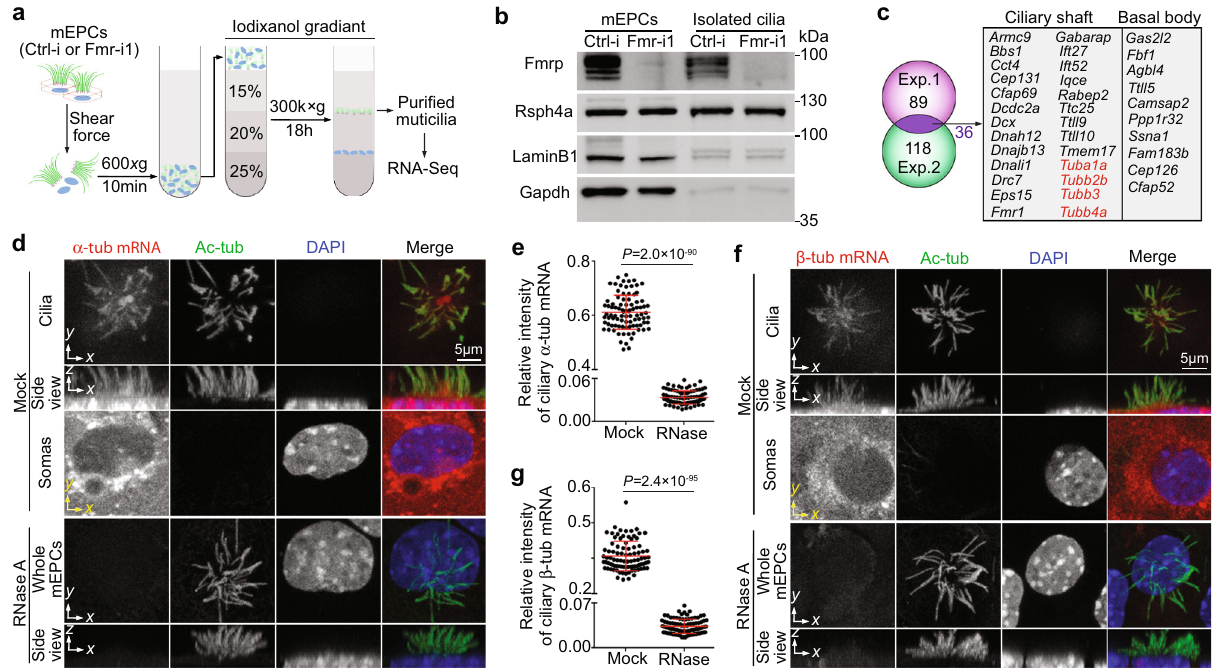
Fig. 7 Ependymal multicilia contain α / β -tubulin mRNAs. Pooled results are presented as mean ± s.d. Two-tailed student ’ s t -test. a Experimental scheme for multicilia puri fi cation. Day-10 mEPCs infected, respectively, with Ctrl-i and Fmr-i1 as illustrated in Fig. 4e were subjected to shear force. The released multicilia were puri fi ed through the iodixanol gradient ultracentrifugation and used for RNA deep sequencing to identify potential ciliary mRNAs. b Sample quality shown by immunoblotting. For the multicilia samples, proteins collected after RNA extraction were used. Fmrp was ef fi ciently depleted in mEPCs. Puri fi ed multicilia were largely free of cytosolic (Gapdh) and nuclear (Lamin B1) contaminants. Rsph4a served as cilia marker. c Candidate ciliary mRNAs. 89 and 118 mRNAs coding for cilia-related proteins were respectively found to be downregulated in the Fmr-i1 ciliary samples in two independent experiments (see Supplementary Table 1 for details). The 36 overlapping mRNAs were considered as candidate ciliary mRNAs. Tubulin mRNAs are shown in red. d – g Detection of ciliary α / β -tubulin mRNAs by smFISH. mEPCs fi xed at day 10 were treated with or without RNase A, followed by smFISH to detect the mRNA for α -tubulin ( d ) or β -tubulin ( f ). Ac-tub and DAPI, respectively, labeled cilia and nuclei. For the representative mock-treated samples ( d, f ), z-projected images from z-stacks above and below the dashed yellow line, respectively, are presented to show fl uorescent signals in cilia and soma regions. For the representative RNase-treated samples ( d, f ), the z-projected images were from the entire z-stacks. Quanti fi cation results ( e, g ) were pooled from three independent experiments. 30 multiciliated mEPCs were measured in each experiment and condition. For each cell, the total ciliary FISH intensity was normalized to that of